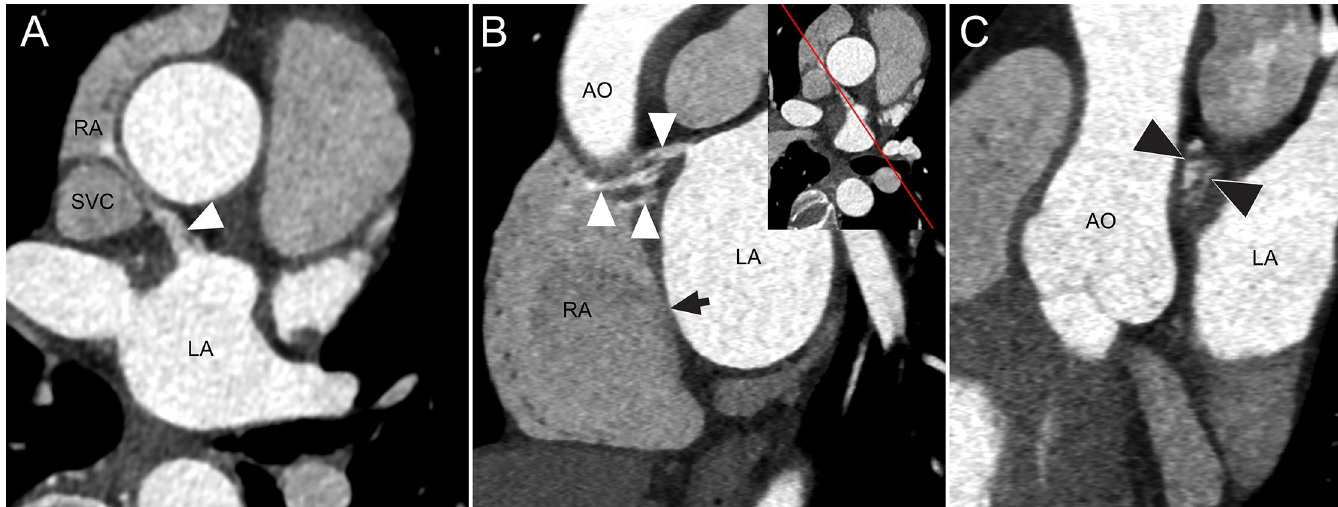
Fig 4. CT Images of an IAC in a 61-year-old female with Marfan syndrome. (A) Axial CT image shows a communication channel (arrowhead) between the left atrium (LA) and right atrium (RA) near the junction of the RA and superior vena cava (SVC). (B) Oblique sagittal reformatted CT image shows openings of multiple channels on the right atrial side and one channel on the left atrial side with varying thickness of the channels (2.4–4.3 mm) and length (16.5–20.8 mm). Insert image shows the direction of sagittal reformation. High attenuation of contrast-enhanced blood in the communication channels (arrowheads) indicates blood shunt from LA to RA. An arrow represents the fossa ovalis. (C) Oblique coronal reformatted image shows multiple small channels (arrowheads) in cross-section. AO, ascending aorta.